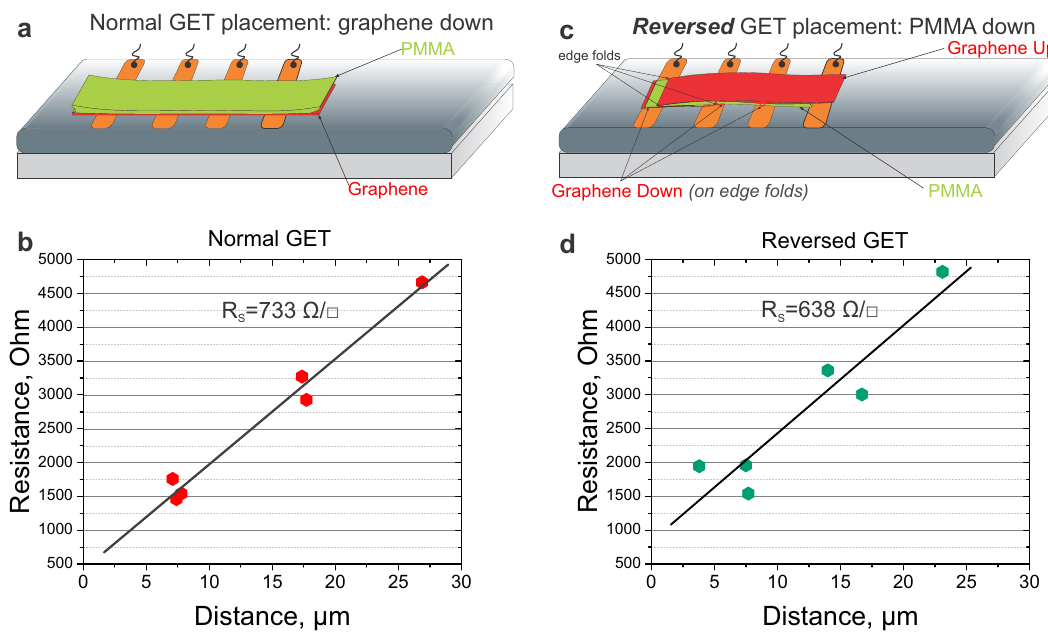
Fig. 4 Sheet resistance and electrical contacts to Normal GETs and Reversed GETs. a , b An example of the 4-probe TLM measurement results with standard graphene tattoo placement (graphene down). c The opposite situation: the GET is placed upside-down with graphene up. However, the tattoo is not perfectly fl at, and the edges and corners of the GETs typically fold during transfer. Hence, even when GET is placed with graphene up, a few graphene areas face down, establishing adequate electrical contact with the underlying gold. d The TLM measurement for one of such devices yields the Rs of 638 Ohm/sq. The average Rs for all such devices ( N = 2) is 555 ± 116